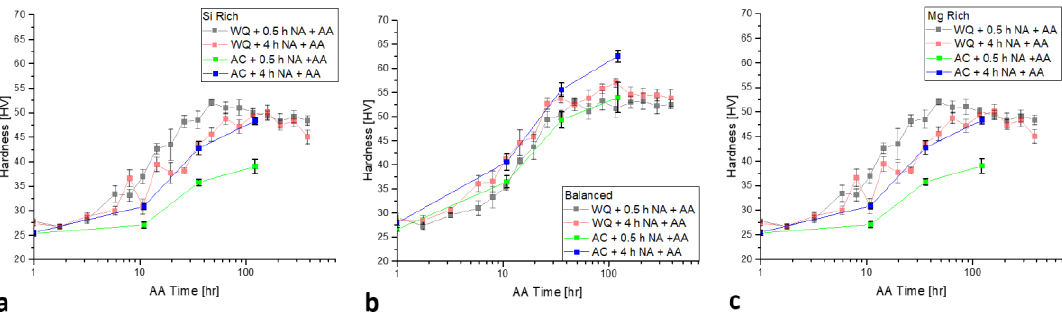
Figure 12. Low strength alloy AA hardness evolution after AC and WQ, for both prior NA conditions (labelled accordingly). WQ results are included, and plotted semi-transparently, for comparative purposes. Error bars represent 95% confidence.